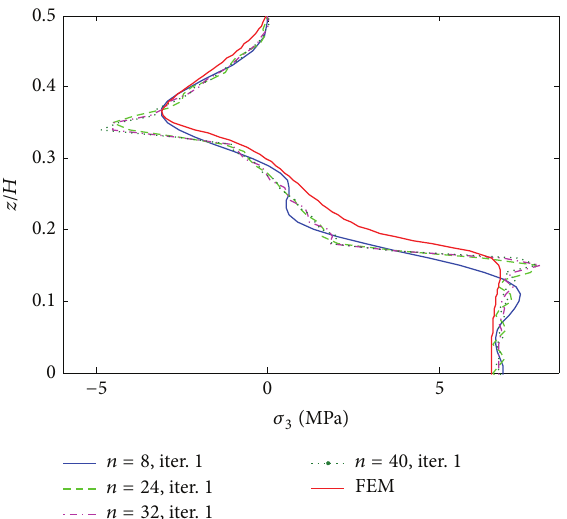
Figure 2: 𝜎 3 distribution of [PZT/0 4 /90 4 ]s laminate at the free edge, using different terms, under 0.1% uniaxial strain.